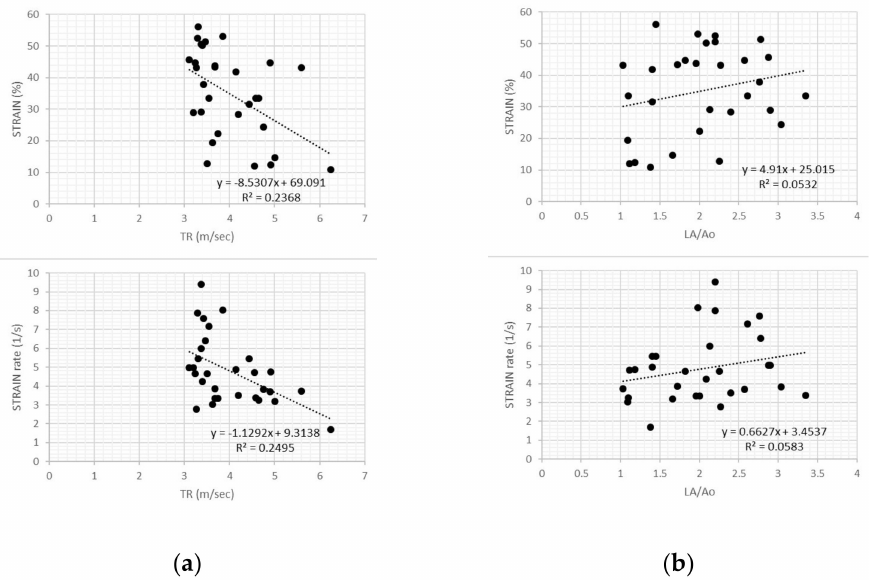
Figure 4. ( a ) Scatter plot of transverse strain and strain rate values in dogs with pulmonary hypertension showed weak negative relationships with tricuspid regurgitation velocity for both variables. TR, tricuspid regurgitation; ( b ) Scatter plot of transverse strain and strain rate values in dogs with pulmonary hypertension showed no relationship with left atrial size ( LA / Ao ) for both variables. Intra- and inter-observer measurement variability for transverse strain values was 9.69% and 10.98%, respectively. For transverse strain rate values, intra- and inter-observer measurement variability was 20.65% and 22.78%,